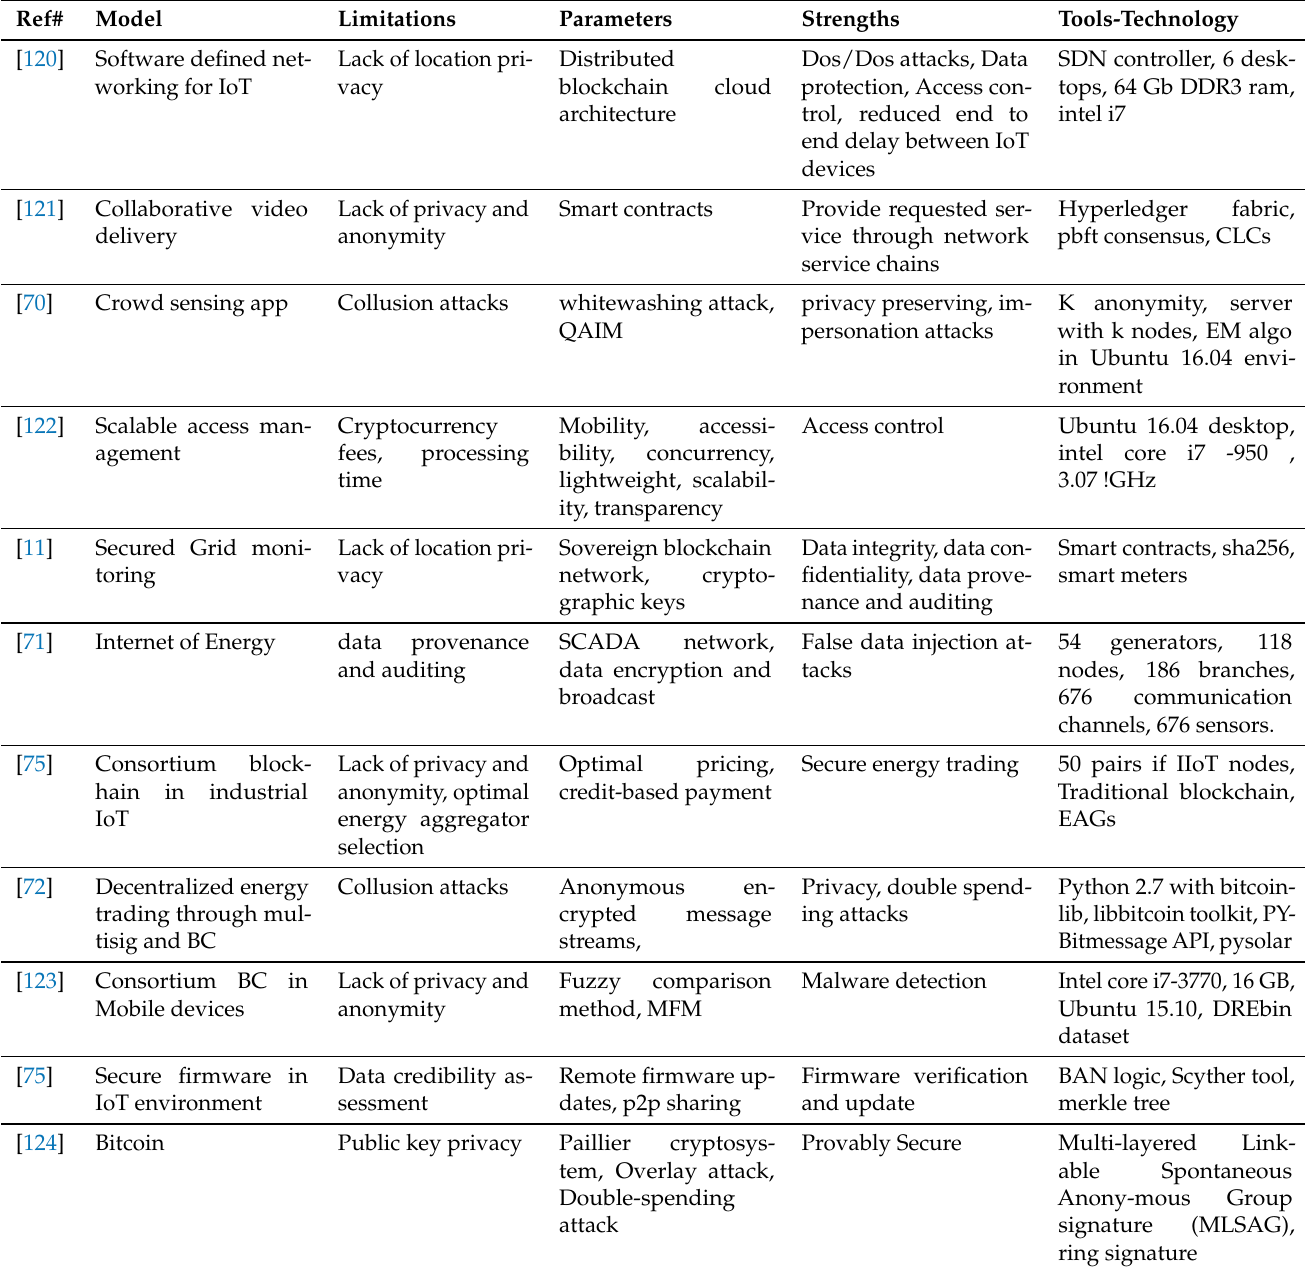
Table 6. Recent research on blockchain-based privacy preservation in